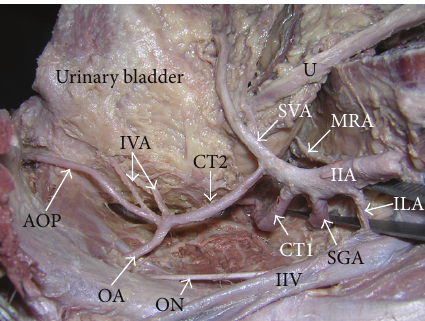
Figure 1: Superior view of the left hemipelvis. (AOP: artery of penis,